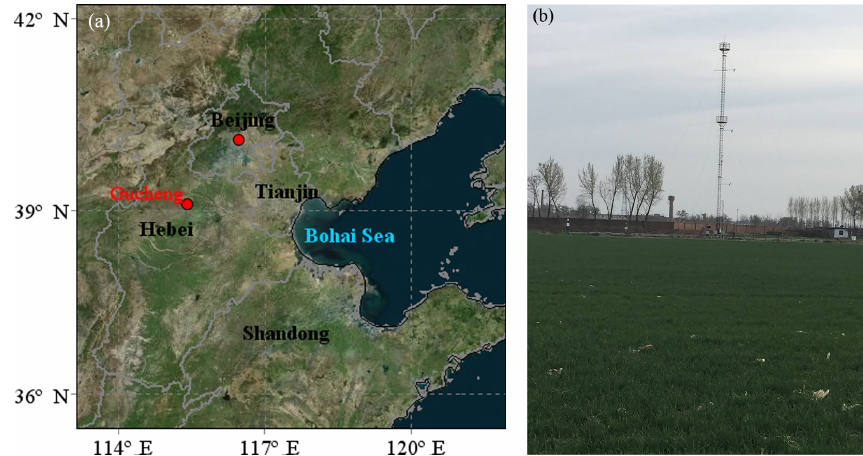
Figure 1. Location (a) and geographical environment (b) at Gucheng station. The map is from Bing Maps.